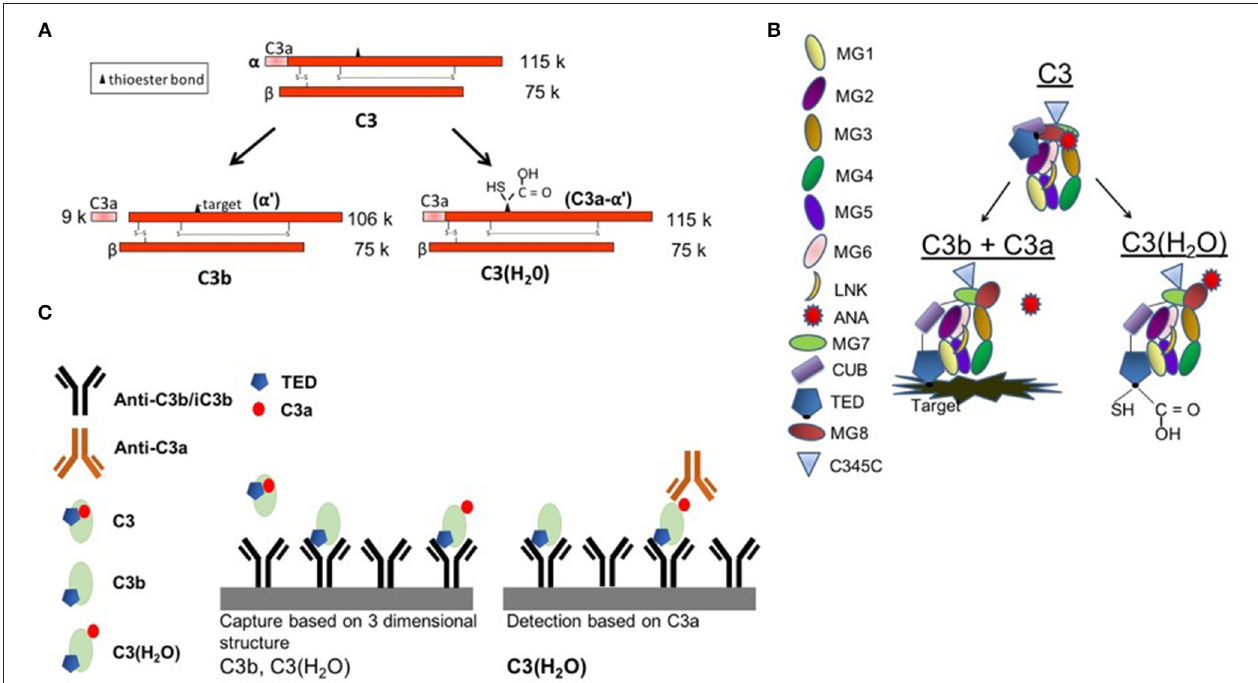
FIGURE 1 | C3(H 2 O) ELISA set-up. (A) Schematic depicting C3, C3b, and C3(H 2 O). (B) Diagram showing protein domains and the conformational rearrangement following C3 activation to either C3b (with liberation of C3a) or C3(H 2 O) (with a hydrolyzed thioester and retention of C3a). Note the movement of the ANA domain (red) and the TED domain (dark blue). Diagram adapted from Janssen et al. (34, 35) and Gros et al. (36). (C) C3b and C3(H 2 O) are recognized by the capture antibody (3E7, mouse anti-C3b/iC3b). C3 is not captured. C3(H 2 O) is recognized based on the presence of the C3a (ANA) domain in the detection step. MG1-8, macroglobulin domains 1-8; LNK, linker domain; ANA, anaphylatoxin domain; α ′ NT, n-terminus of the α -chain; CUB, complement C1r/C1s, UEGF, BMP1; TED, thioester-containing domain; C345C, netrin (NTR)